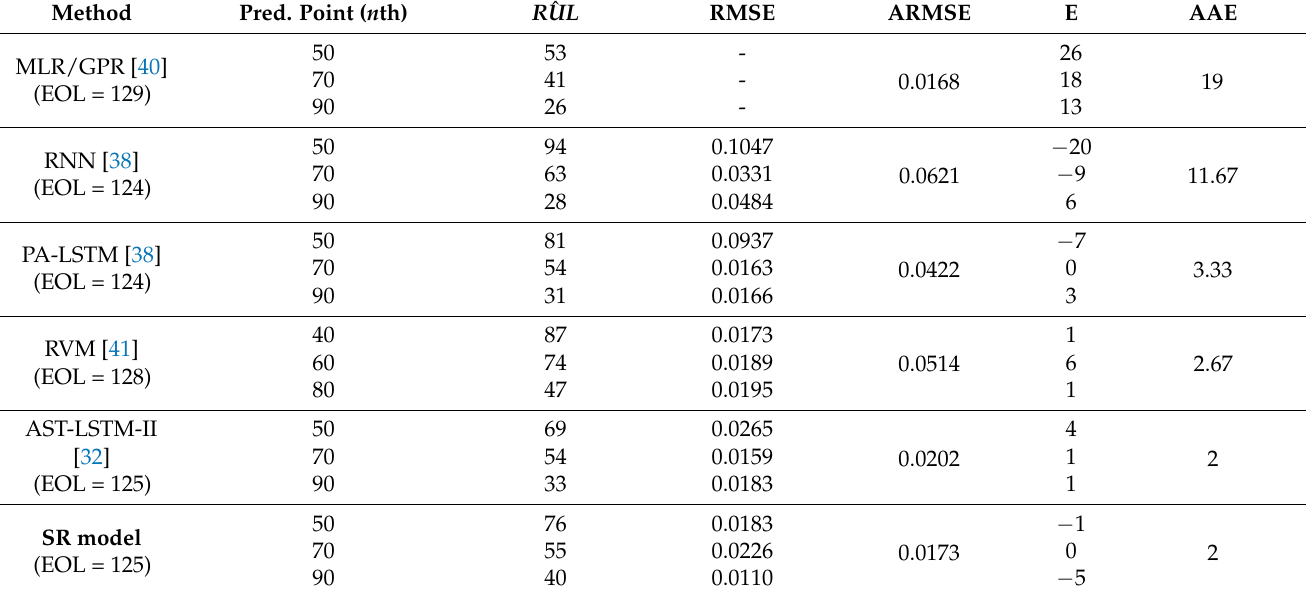
Table 6. The errors generated by several methods for the RUL prediction of battery #B0005 with different predicting (Pred.)